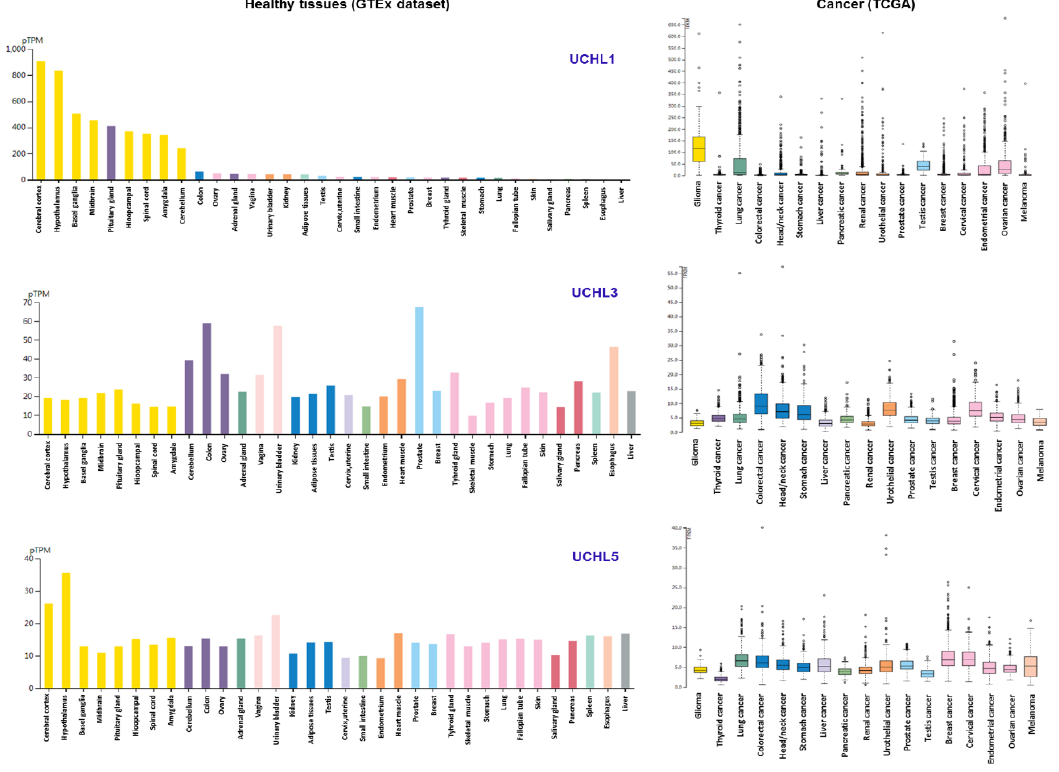
Figure 1. The expression analysis of ubiquitin C-terminal hydrolases (UCHs) UCH-L1 , UCH-L3 , and UCH-L5 in healthy tissues and in 17 cancer types. The expression analysis of UCH-L1 , UCH-L3 , UCH-L5 in 34 healthy tissues extracted from GTEx database. The expression is represented with TPM (tags per million clean tags). The clear enrichment of UCH-L1 in CNS and equal distribution of UCH-L3 , UCH-L5 in all tissue types is shown (Left panel). The expression analysis of UCH-L1 , UCH-L3 , UCH-L5 in 17 cancer types extracted from The Cancer Genome Atlas (TCGA) project (https://portal.gdc.cancer.gov/). Boxplot indicates gene expression fragments per kilobase of exon per million reads (FPKM) in cancer samples (Right panel).